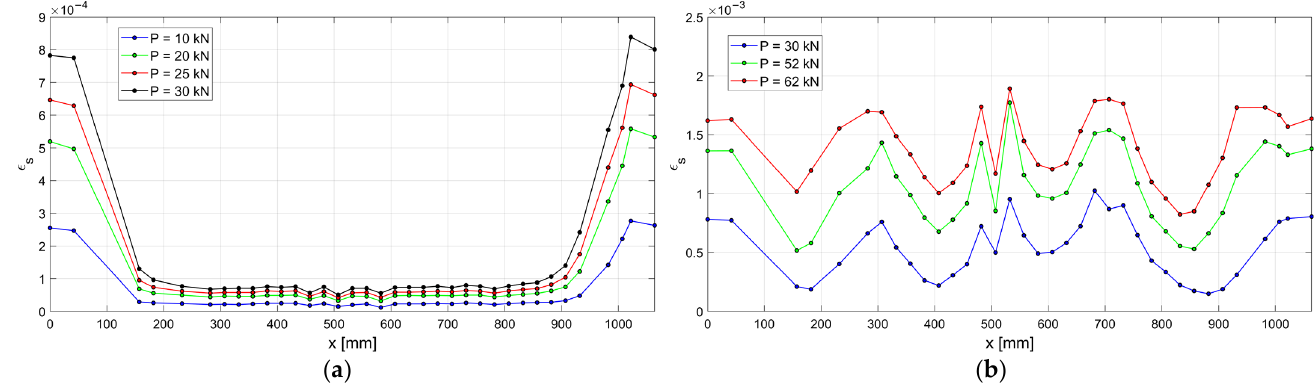
Figure 11. Experimental ε-x curves of the n.1 r.c. tie: ( a ) P < 30 kN, ( b ) 30 kN ≤ P ≤ 60 kN.